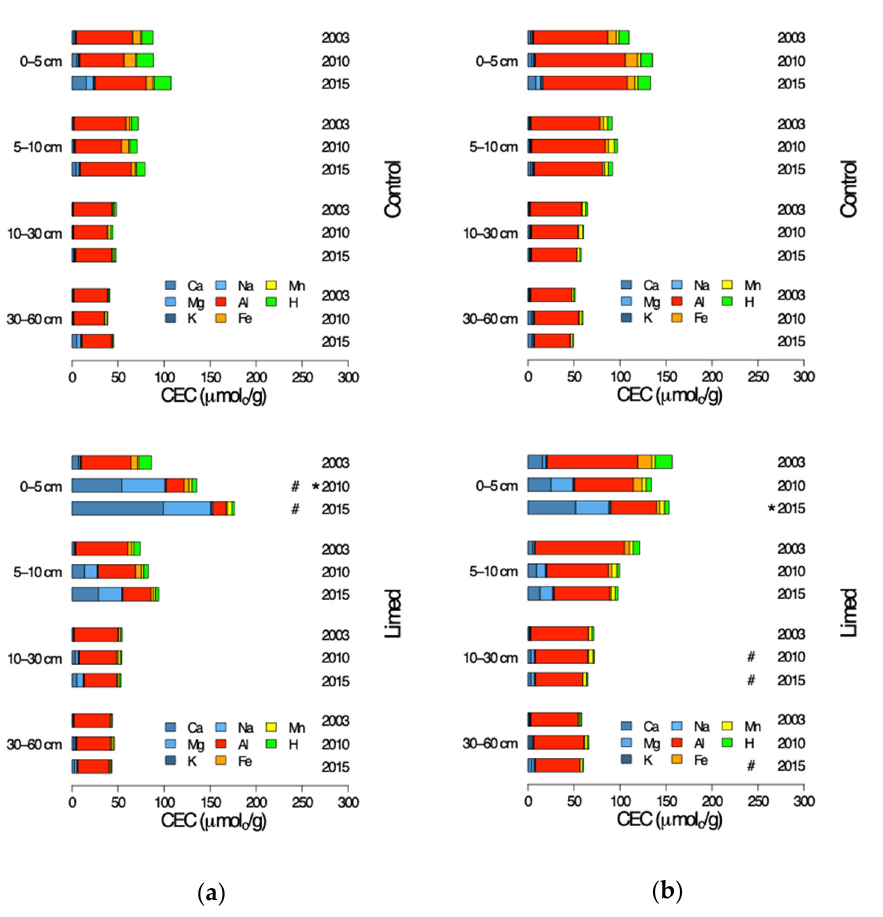
Figure 6. Control plot exchangeable cations (CEC) in the soil profile of the control and limed plots 2003–2015: ( a ) G1 sites and ( b ) G2 sites. #—limed plots significantly different from control; *—significant differences between current and previous sampling campaign.